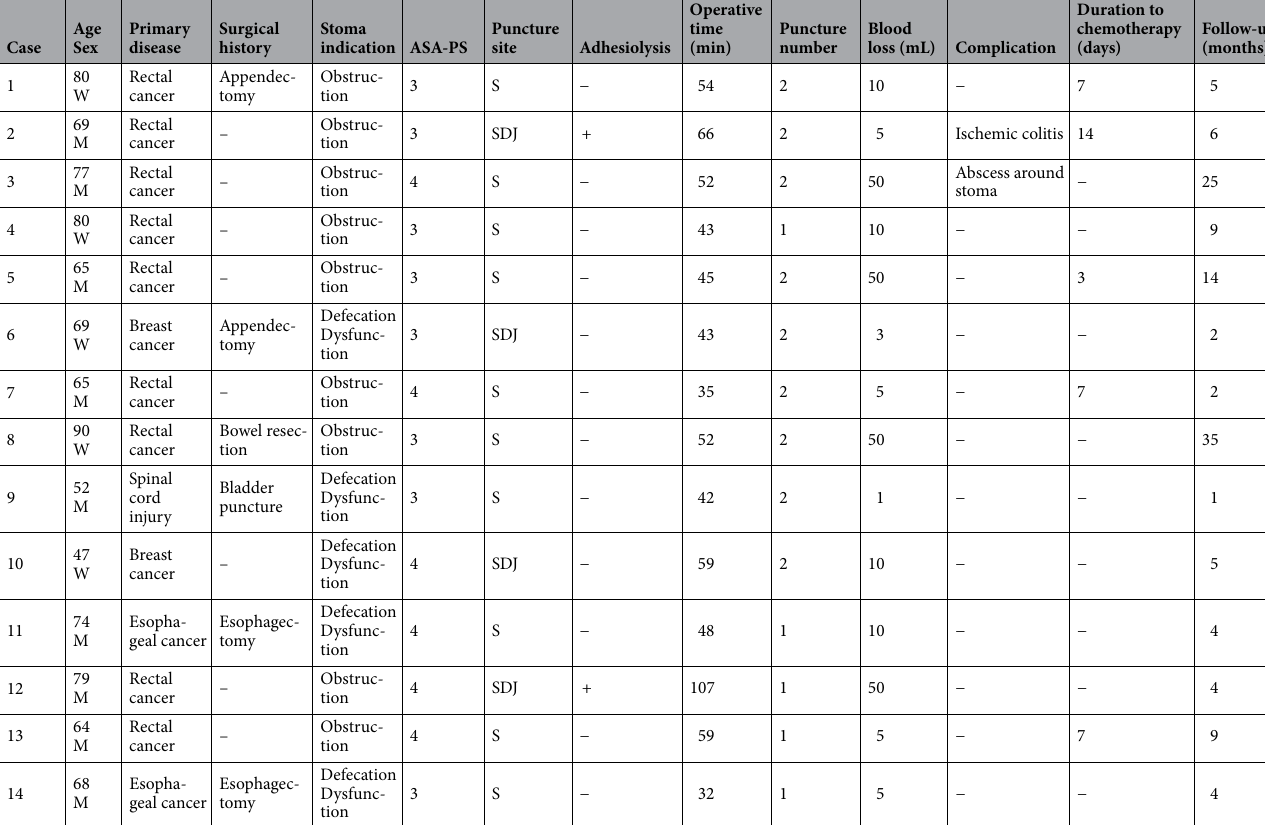
Table 1. Patient characteristics and procedures. ASA- PS American Society of Anesthesiologists physical status classification, S sigmoid colon, SDJ sigmoid-descending colon